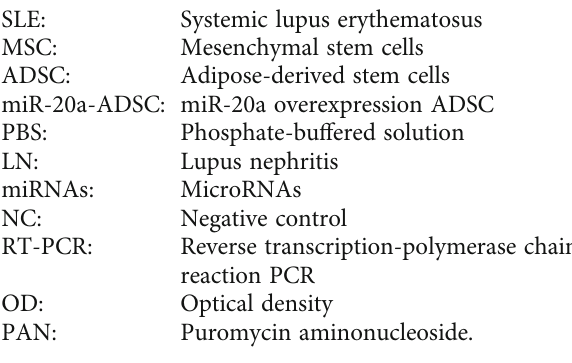
Supplementary Figure 1: original western blot. (A) Western blot of cleaved caspase-3. (B) Western blot of GAPDH.